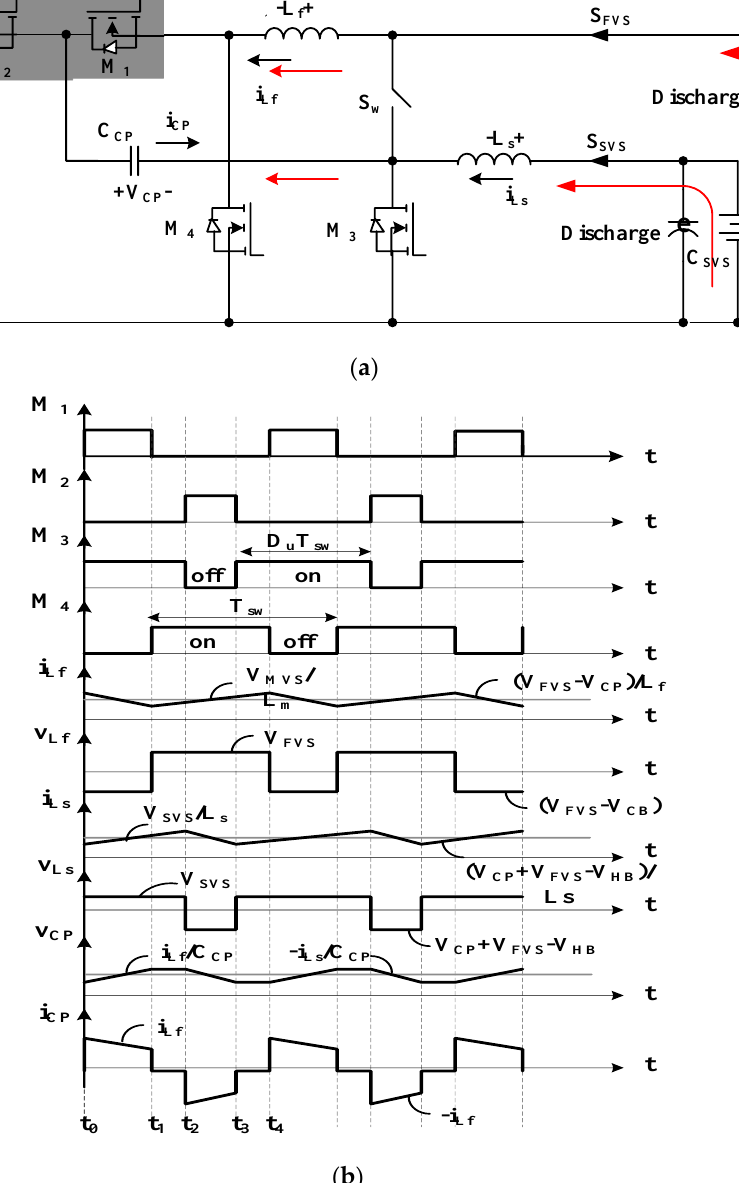
Figure 3. ( a ) Schematic Diagram. ( b ) Waveforms of BDC’s dual low-voltage sources powering